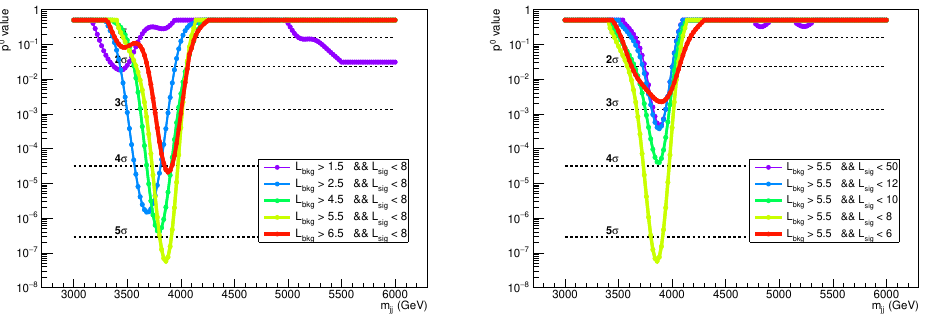
Figure 7 . Scan of the p-value significance in the dijet mass performed on a fit to the dijet mass distribution for (a) a tight selection on the signal loss L sig and varied selections on the background loss L bkg , and for (b) a tight selection on the background loss L bkg and a varied selection on signal loss L sig . The significance is quoted is obtained from the asymptotic CLs